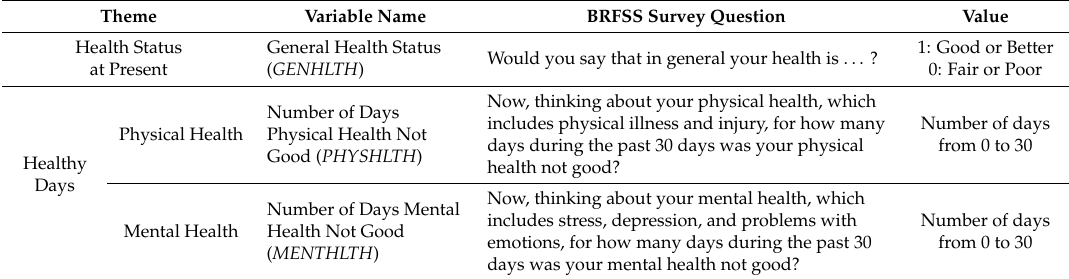
Table 1. Individual-level measures for self-rated health from the Behavioral Risk Factor Surveillance System (BRFSS) 2011.